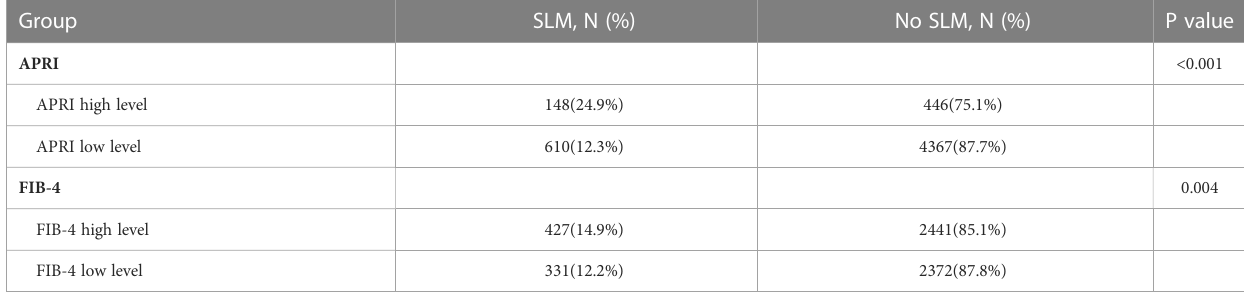
TABLE 4 Effect of liver cirrhosis index on CRLM in non-HBsAg+ group.